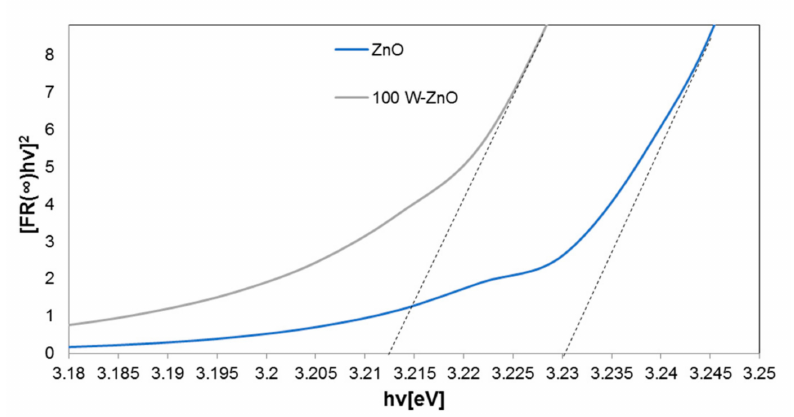
Figure 3. Calculation of band gap for undoped (ZnO) and doped photocatalysts (100 W-ZnO) .